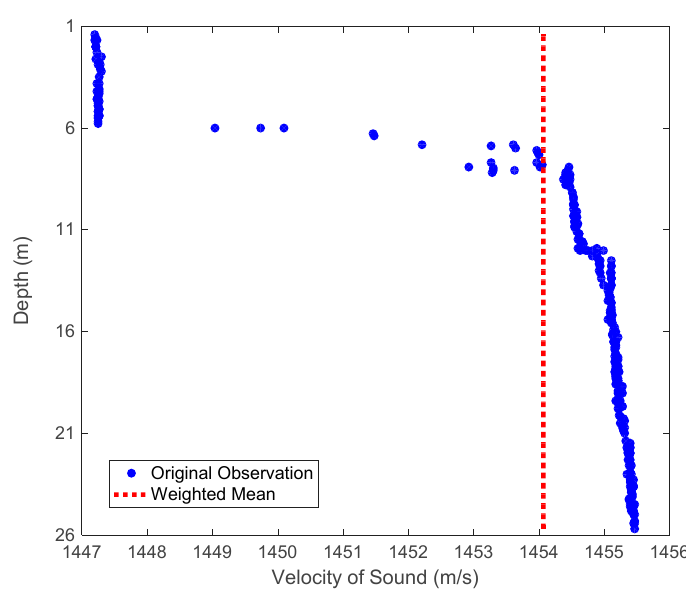
Figure 3. The sound velocity profiles.